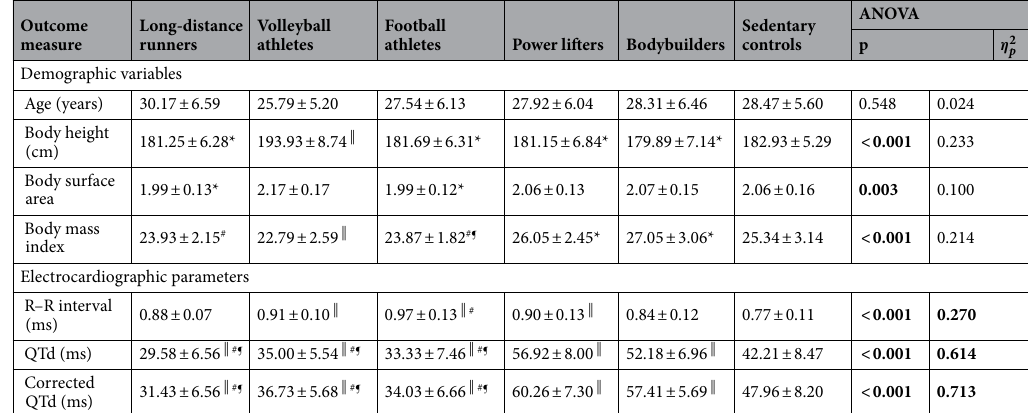
Table 2. Demographic variables (mean ± standard deviation) and electrocardiographic parameters in long-distance runners (n = 12), volleyball athletes (n = 14), football athletes (n = 39), powerlifters (n = 26), bodybuilders (n = 39), and sedentary controls (n = 43). Bolded p values indicate statistically significant 2 difference (p < 0.05), bolded η p indicate moderate to strong effects; body surface area = 0.007184 * height * body mass 0.425 . QTd QT dispersion. *Significantly different from volleyball athletes. # Significantly different from bodybuilders. ¶ Significantly different from powerlifters. ║ Significantly different from sedentary